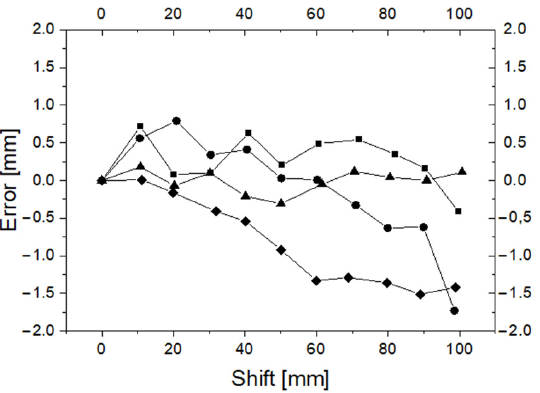
Figure 11. Differences (error) between D1 and reference frame readings. The different symbols correspond to four measurement series.